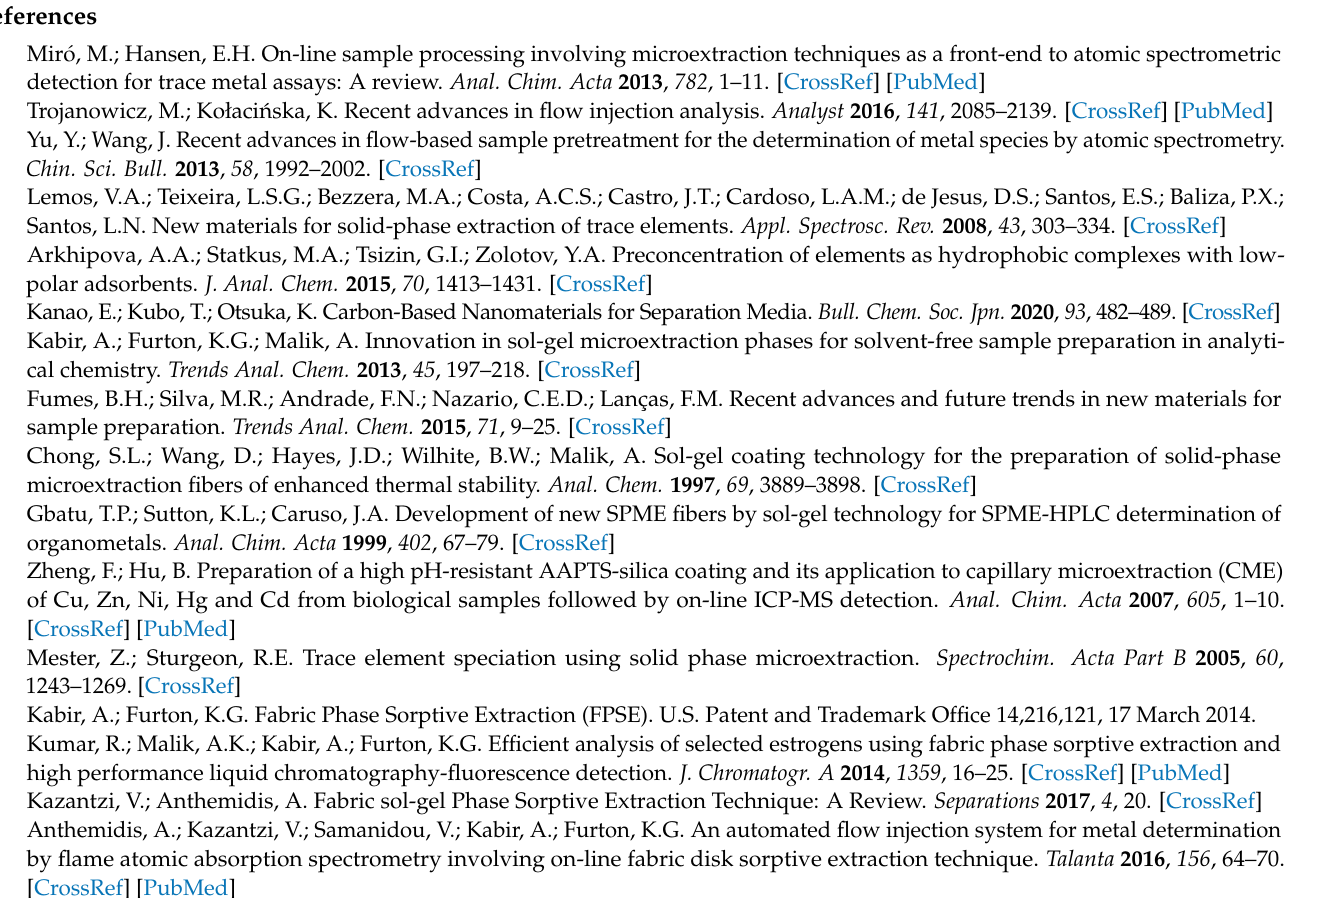
Supplementary Materials: The following are available online, Figure S1. Preparation of the mi- crocolumn packed with glass fiber sol–gel PDPS; (a) cutting of glass fibers; (b) packing with GF sol–gel PDPS, Figure S2. Installation of the GFSE microcolumn in the FIAS-400 system, Figure S3. Effect of sample flow rate on the absorbance of 100.0 µ g · L − 1 Pb(II) and 100.0 µ g · L − 1 Cr(VI). All other experimental parameters as in Table 1, Figure S4. Effect of elution flow rate on the absorbance Figure S5. Effect of preconcentration time on the absorbance of 100.0 µ g · L − 1 Pb(II) and 100.0 µ g · L − 1 Cr(VI). All other experimental parameters as in Table